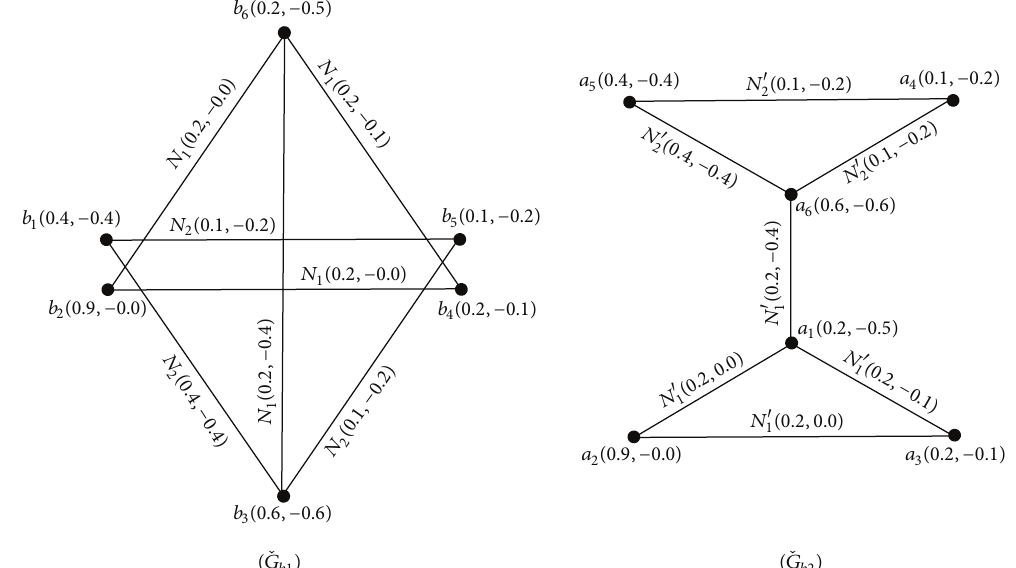
Figure 9: Identical bipolar fuzzy graph